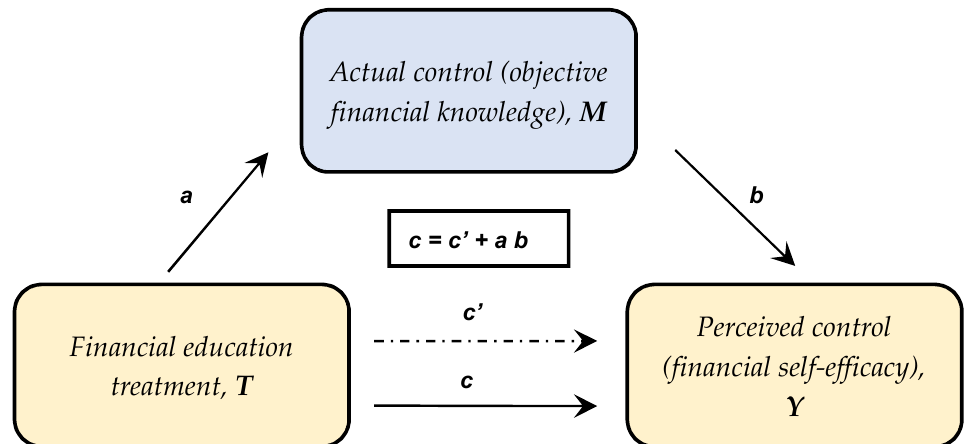
Figure 2. Schematic diagram of the hypothesized mediation model. Source: author’s